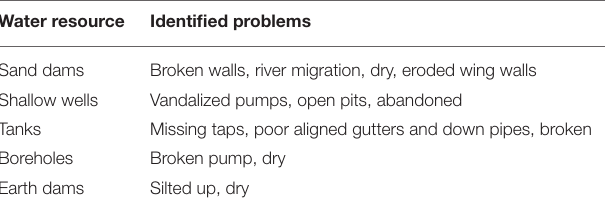
TABLE 2 | Problems related to water